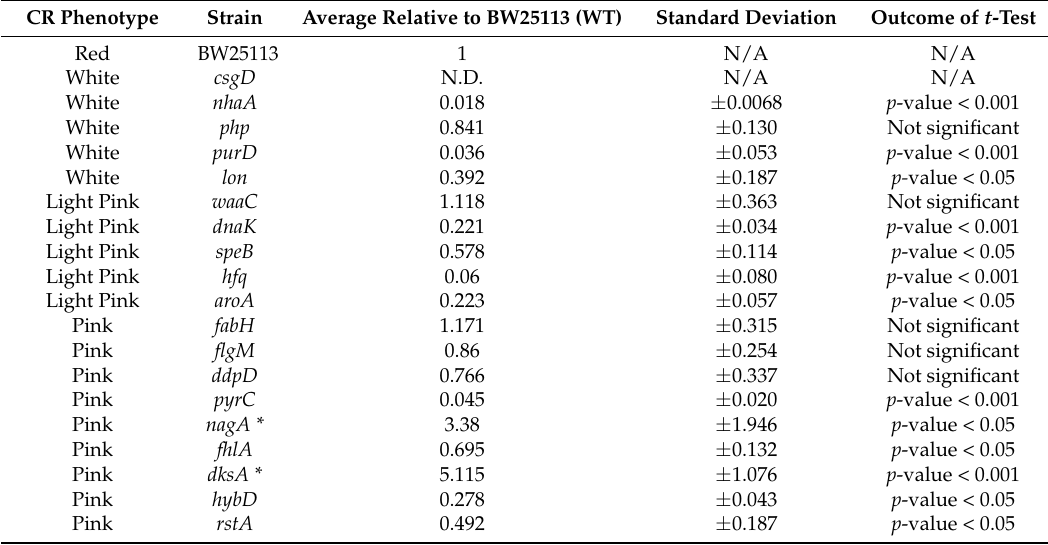
Figure 7. CsgD protein levels are changed in several mutants. A representative western blot is shown for the data presented in Table S9. CsgD protein levels are shown in green and σ 70 levels are shown in red as a loading control. CsgD levels were normalized to σ 70, and then each mutant was normalized to WT to yield the relative CsgD protein levels for each mutant list of genes. σ 70 migrates father in the hybD line consistently over multiple trials on different days. Table 2. Selected mutant csgD levels as compared to WT.